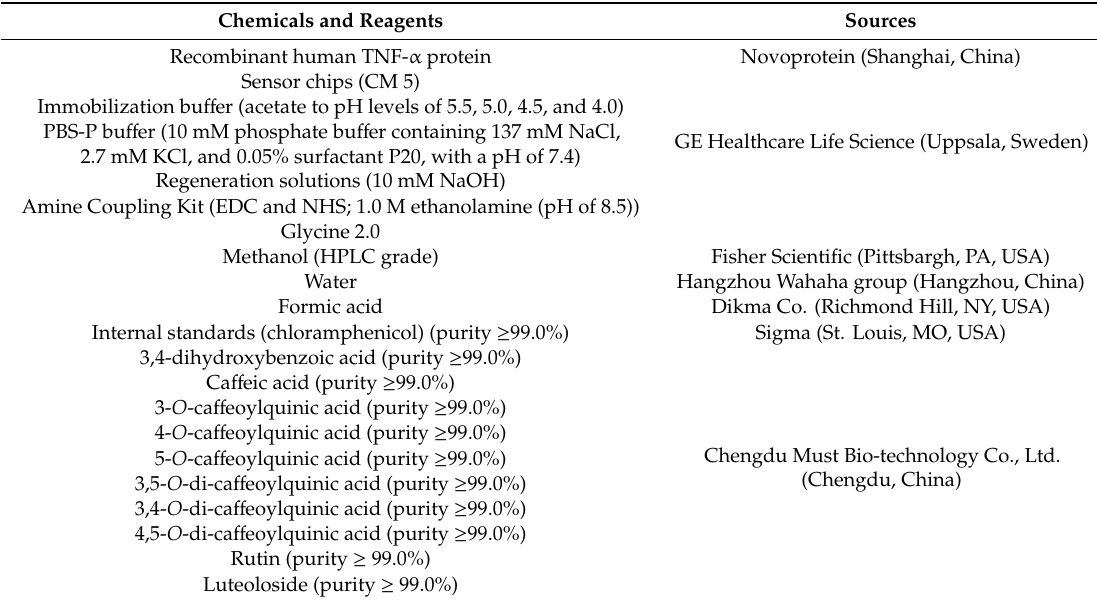
Table 5. Experimental chemicals and